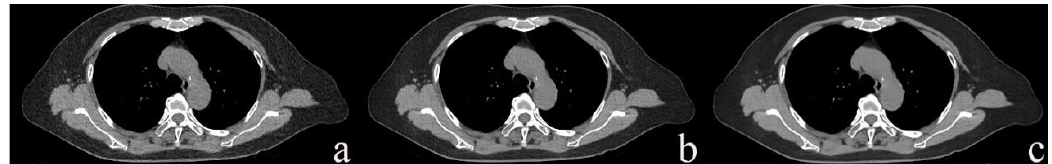
Table 5. Results of the subjective image analysis.